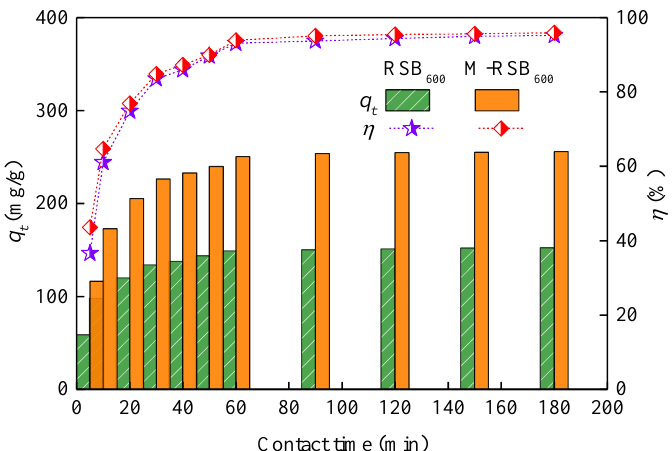
Figure 7. The adsorption performance under different contact time.